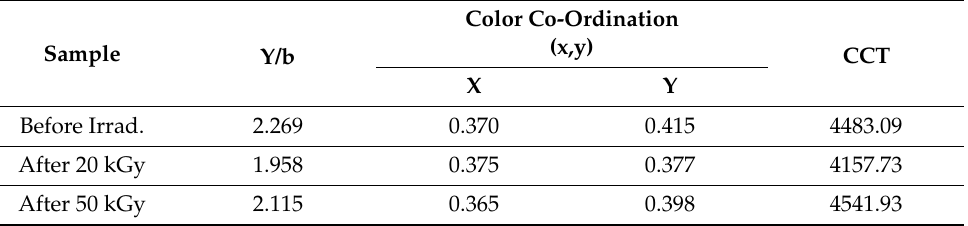
Table 3. Yellow to blue integrated intensity ratios, average decay time, chromaticity color coordinates, and CCT of GRD glasses before and after irradiation. Color Co-Ordination (x,y) CCT Sample Y/b X Y Before Irrad. 2.269 0.370 0.415 4483.09 After 20 kGy 1.958 0.375 0.377 4157.73 After 50 kGy 2.115 0.365 0.398